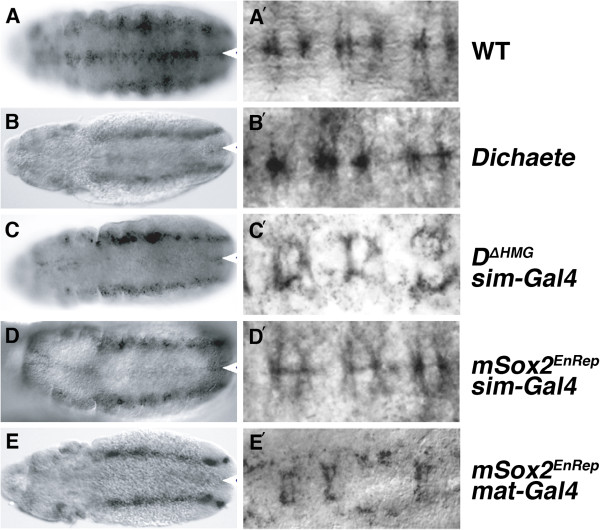
Commisureless is a Dichaete target in the midline.  Ventral views of stage 12 (A-E) and close-up of the midline in stage 14 (A’ – E’) embryos stained with anti-Comm. Anterior is to the left and the white arrowheads indicate the midline. A and A’) Wild type; B and B’) Dr72/Df(3L)fz-GS1a; C and C’) sim-GAL4; UAS-DΔHMG; D and D’) sim-GAL4; UAS-mSox2EnRep; E and E’) Maternal-GAL4VP16; UAS-mSox2EnRep
.